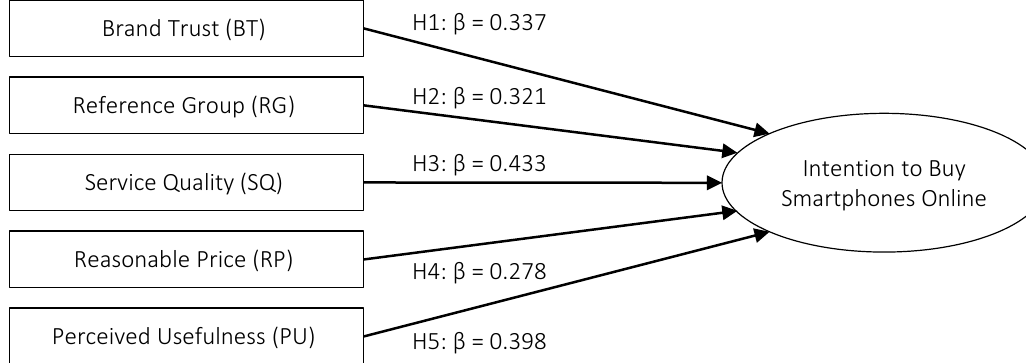
Intention to Buy